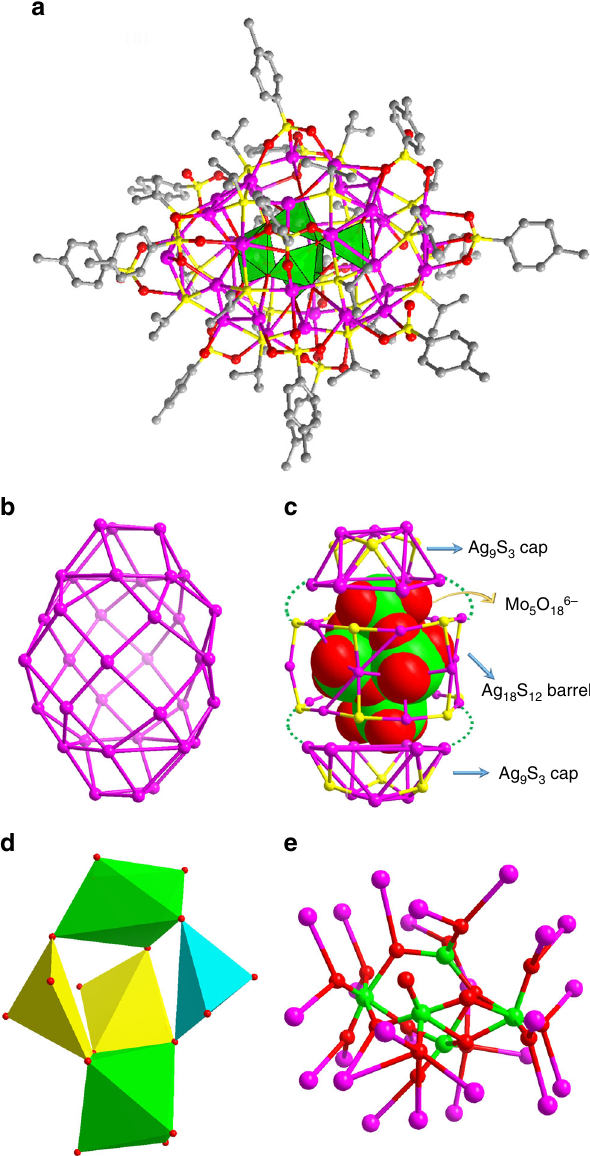
Fig. 5 Single-crystal structure of SD/Ag12 . a The total structure of SD/ Ag12 with Mo 5 O 18 6 − shown in polyhedral mode. b The Ag 36 skeleton comprised of Ag 3 trigons and Ag 4 tetragons. c Schematic showing one Mo 5 O 18 6 − enwrapped by Ag 18 barrel, then closed by two half- cuboctahedral Ag 9 S 3 caps. d Polyhedral representation of Mo 5 O 18 6 − with two octahedral MoO 6 , two square-pyramidal MoO 5 and one tetrahedral MoO 4 units shown in green, yellow and cyan, respectively. e The bonding between Mo 5 O 18 6 − and Ag atoms at the shell. (Colour legend: purple, Ag; yellow, S; red, O; green,